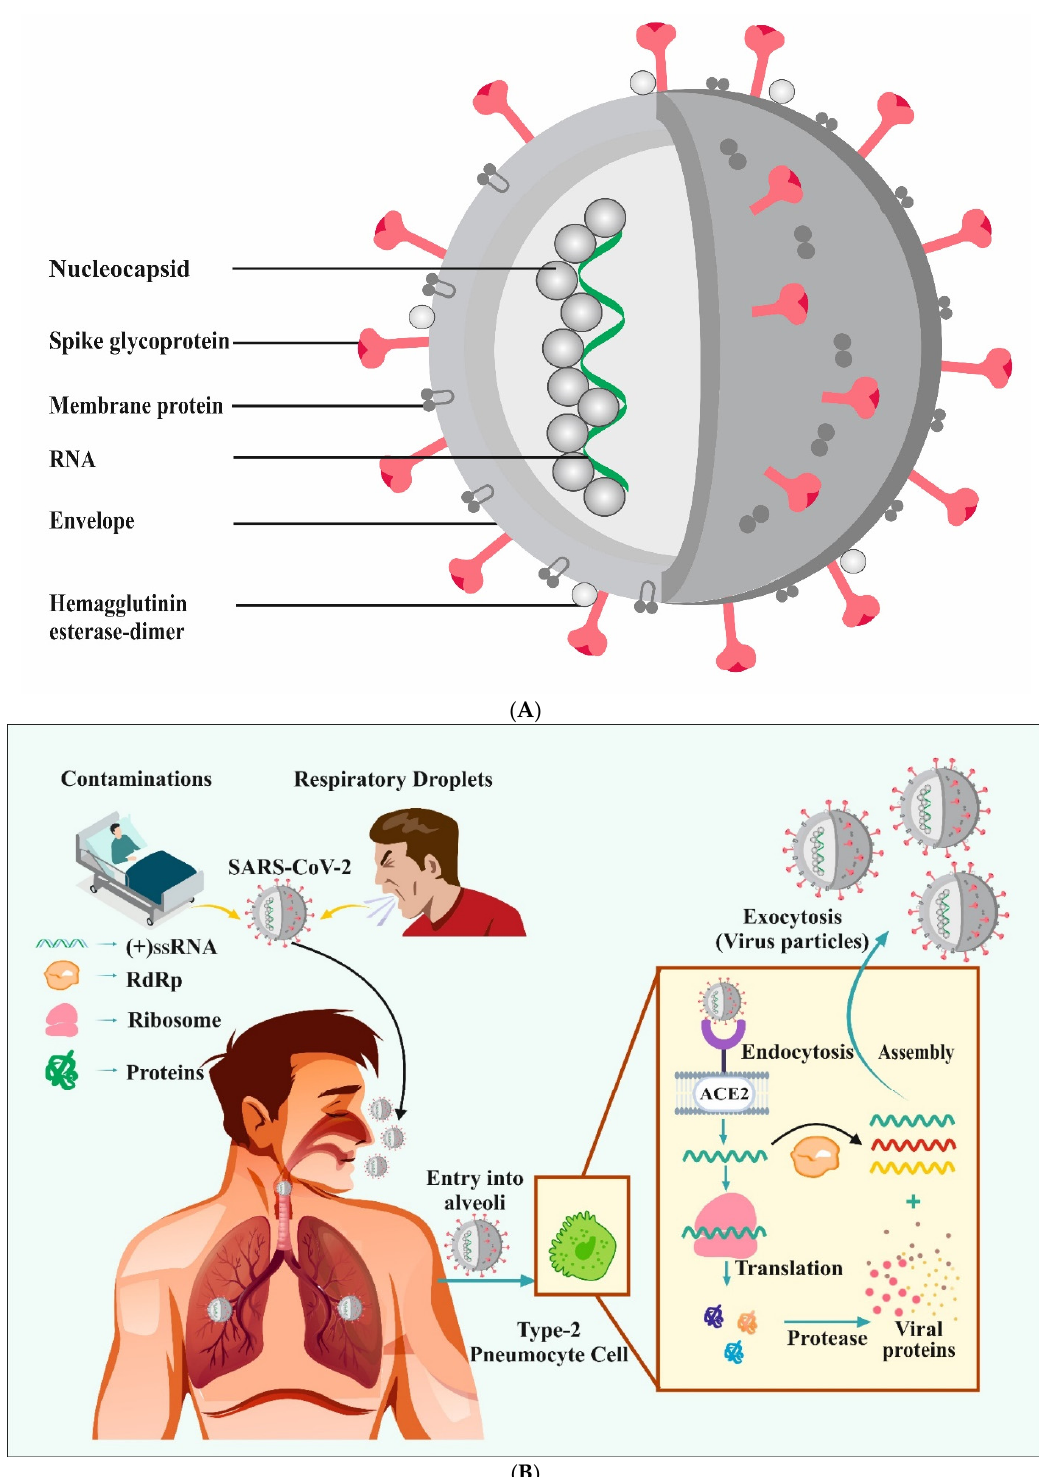
Figure 1. Schematic representation of SARS-CoV-2 structure ( A ). The life cycle of SARS-CoV-2 ( B ). The life cycle is reproduced from [51] under the Creative Commons Attribution (CC BY) license (http://creativecommons.org/licenses/by/ 4.0/) (accessed on 28 September 2021). RdRp: RNA-dependent RNA polymerase; ACE 2: angiotensin-converting enzyme-2